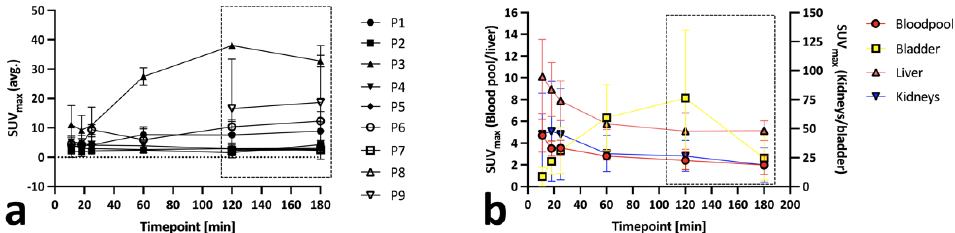
Figure 1. Per-patient 68 Ga-NeoBOMB1 ( a ) and blood pool, bladder, liver, and kidneys time activity curves ( b ) for all nine participants (P1–9). Optimal imaging window for maximum tumor-to-blood pool contrast is represented by the dashed rectangular box ( a ).